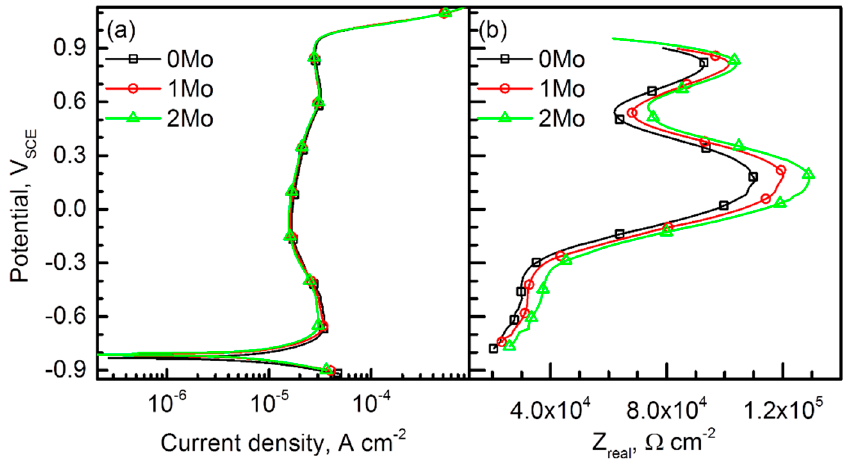
Figure 5. ( a ) Potentiodynamic polarization curves of 0Mo, 1Mo, and 2Mo alloys measured in a borate-phosphate-citric buffer solution (pH 8.5) at 25 °C (d V /d t = 1 mV/s). ( b ) Graphs of real part of the impedance ( Z' real ) versus applied potential of the alloys measured in the same solution by imposing the sinusoidal voltage perturbation (±10 mV) at a frequency of 0.1 Hz.